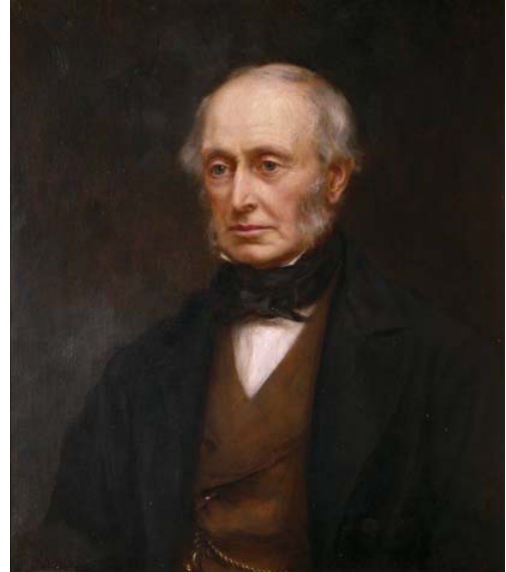
Figure 1. 1st Lord Armstrong of Cragside, by Mary Lemon Waller (1871–1916),